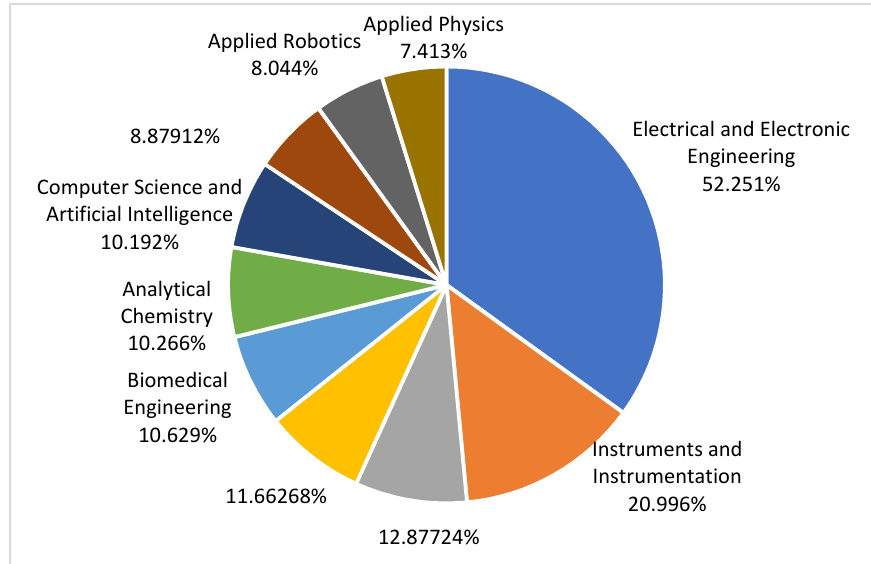
Figure 3. Distribution of studies by technical area.